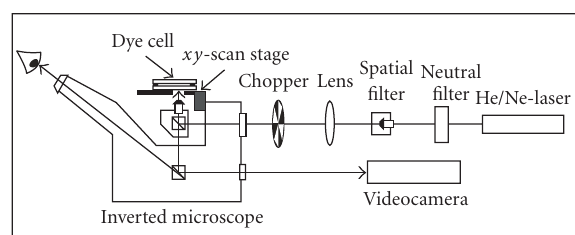
Figure 1: Scheme of the photoelectrochemical set up employing an optical scanning microscope